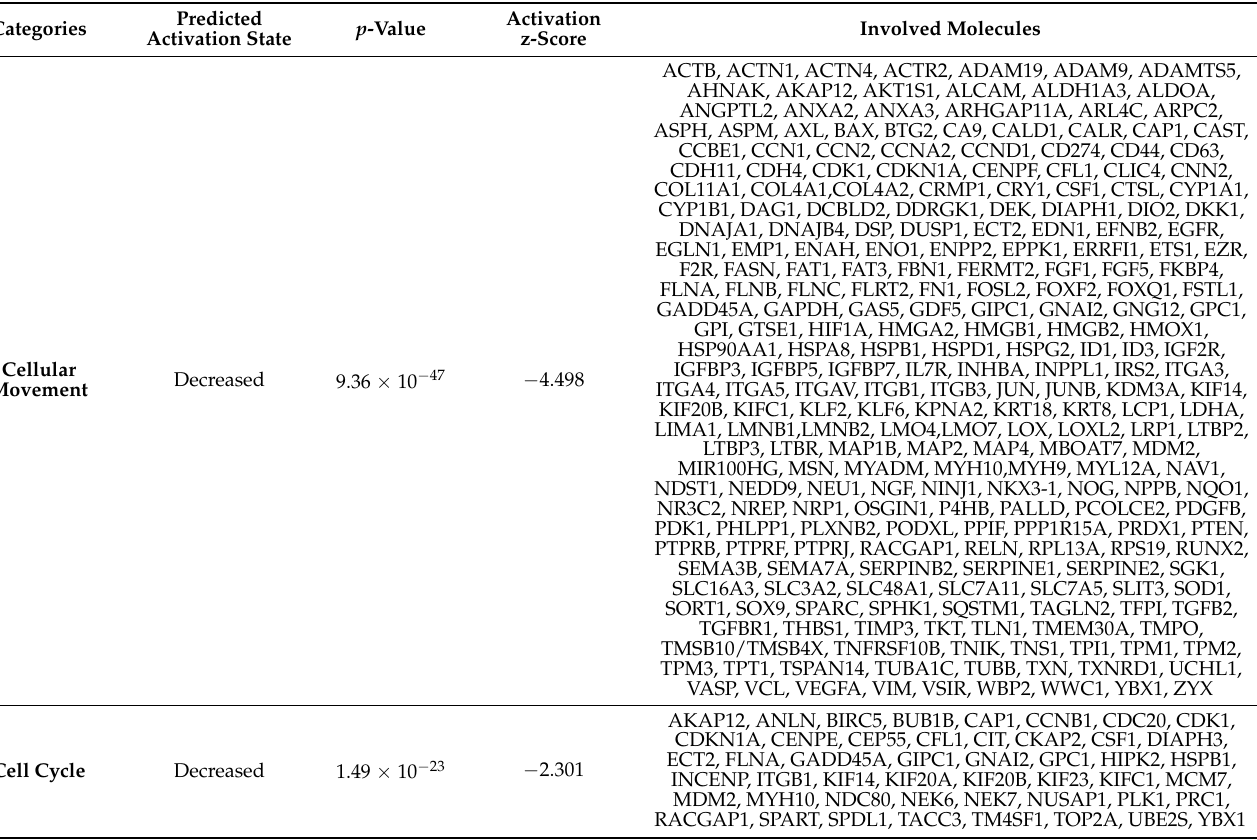
Table 1. Molecules involved in blue-light-induced ARPE-19 cellular